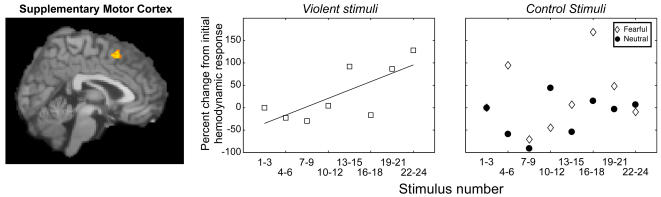
Increased throughput to motor planning regions coincident with diminished regulatory control.The data are analyzed and presented as in figure 2. Exposure to the violent clips induced an increase in supplementary motor response, whereas exposure to the fearful or neutral clips did not (r2
violence = 0.55, p = 0.03; r2
fearful = 0.03, p = 0.67; r2
neutral = 0.12, p = 0.39).